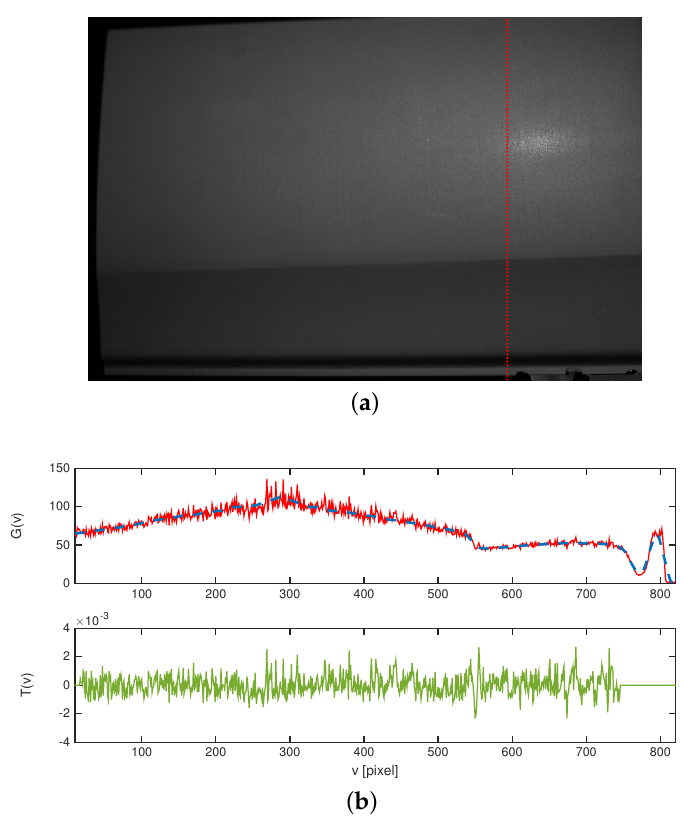
Figure 4. Image data of an unpainted car door panel (see measurement 3, Figure 1). ( a ) Measurement image (blank projection) of an unpainted car door panel; ( b ) Top: Gray scale sequence G i , c (red) and according filtered sequence F i , c (blue, dashed) along one image column. Bottom: resulting normalized, cropped texture T i , c (green) along the image